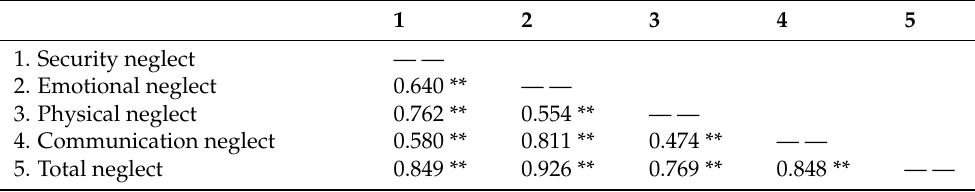
Table 4. Correlations among the total CNS and its four facets.